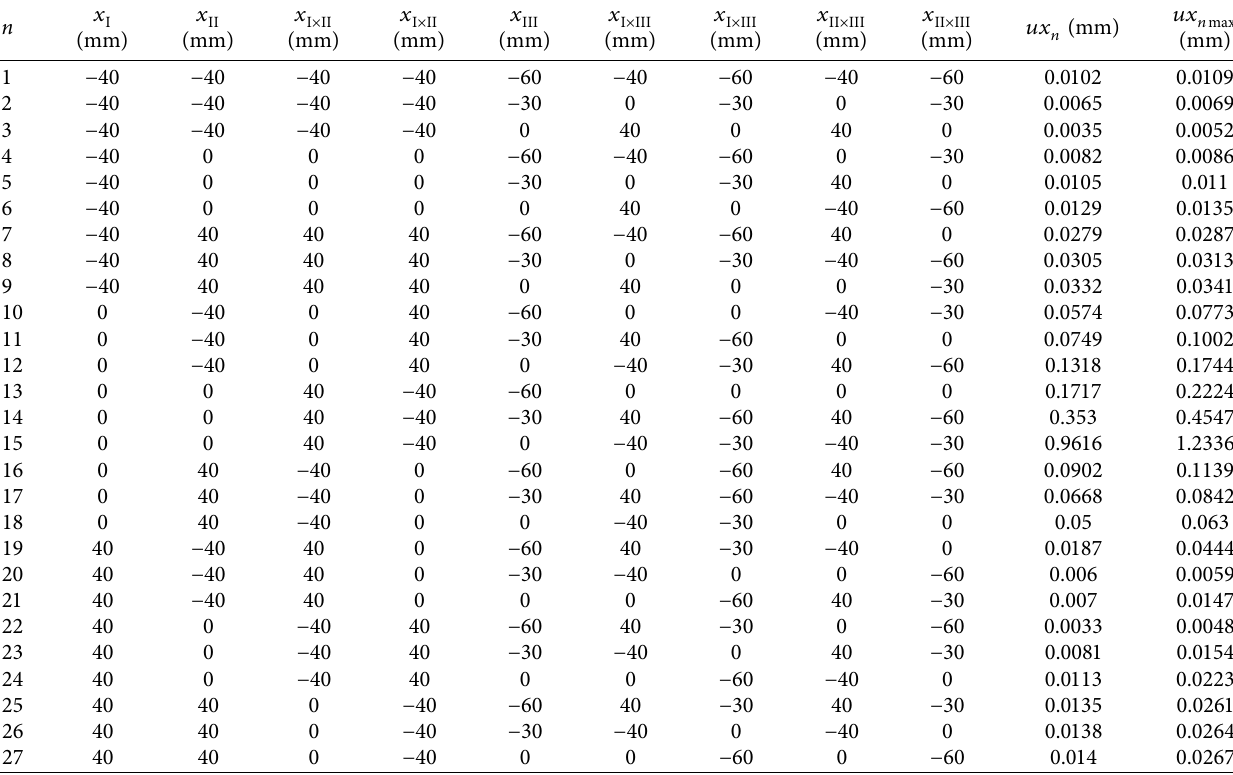
Table 5: Orthogonal test scheme and results of the support position parameters.